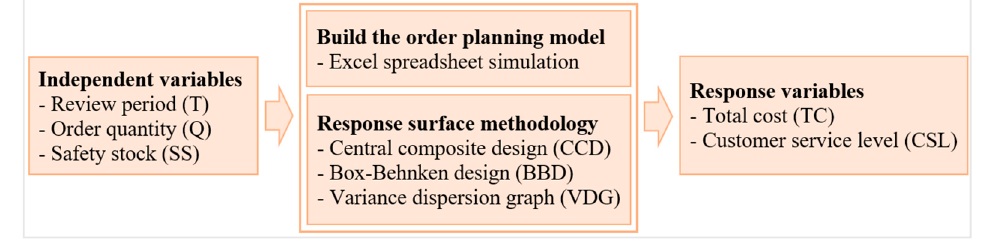
Figure 2. A computational framework.